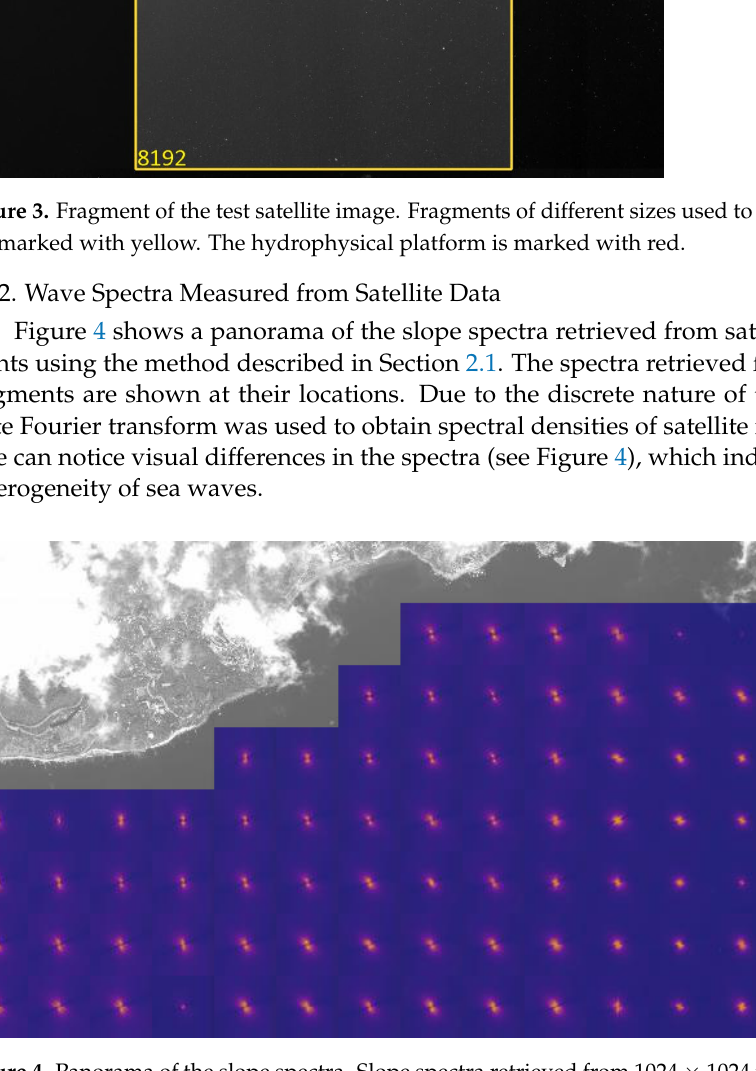
Figure 2. ( a ) Quicklook of a test WorldView-3 image obtained on 20 September 2021. The position of the hydrophysical platform, where complex experiments were carried out, is marked with yellow; ( b ) enlarged view of the hydrophysical platform.